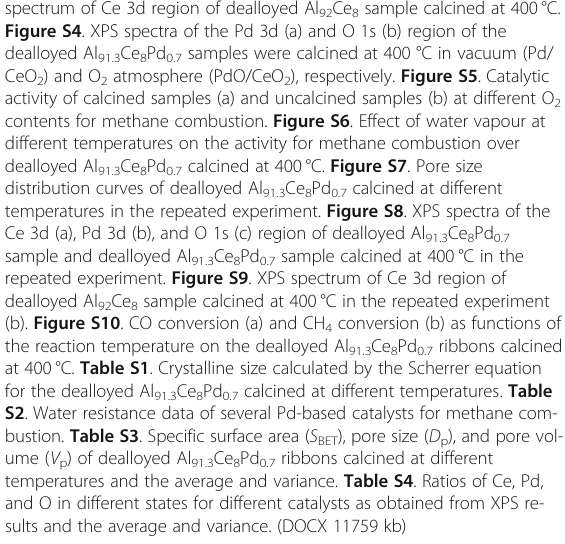
Additional file 1: Figure S1 . Apparatus related to the addition of H 2 O. Figure S2 . SEM (a, c, e, g, i) and TEM (b, d, f, h, j) images of the dealloyed Al 91.3 Ce 8 Pd 0.7 under different calcination temperatures. Figure S3 . XPS